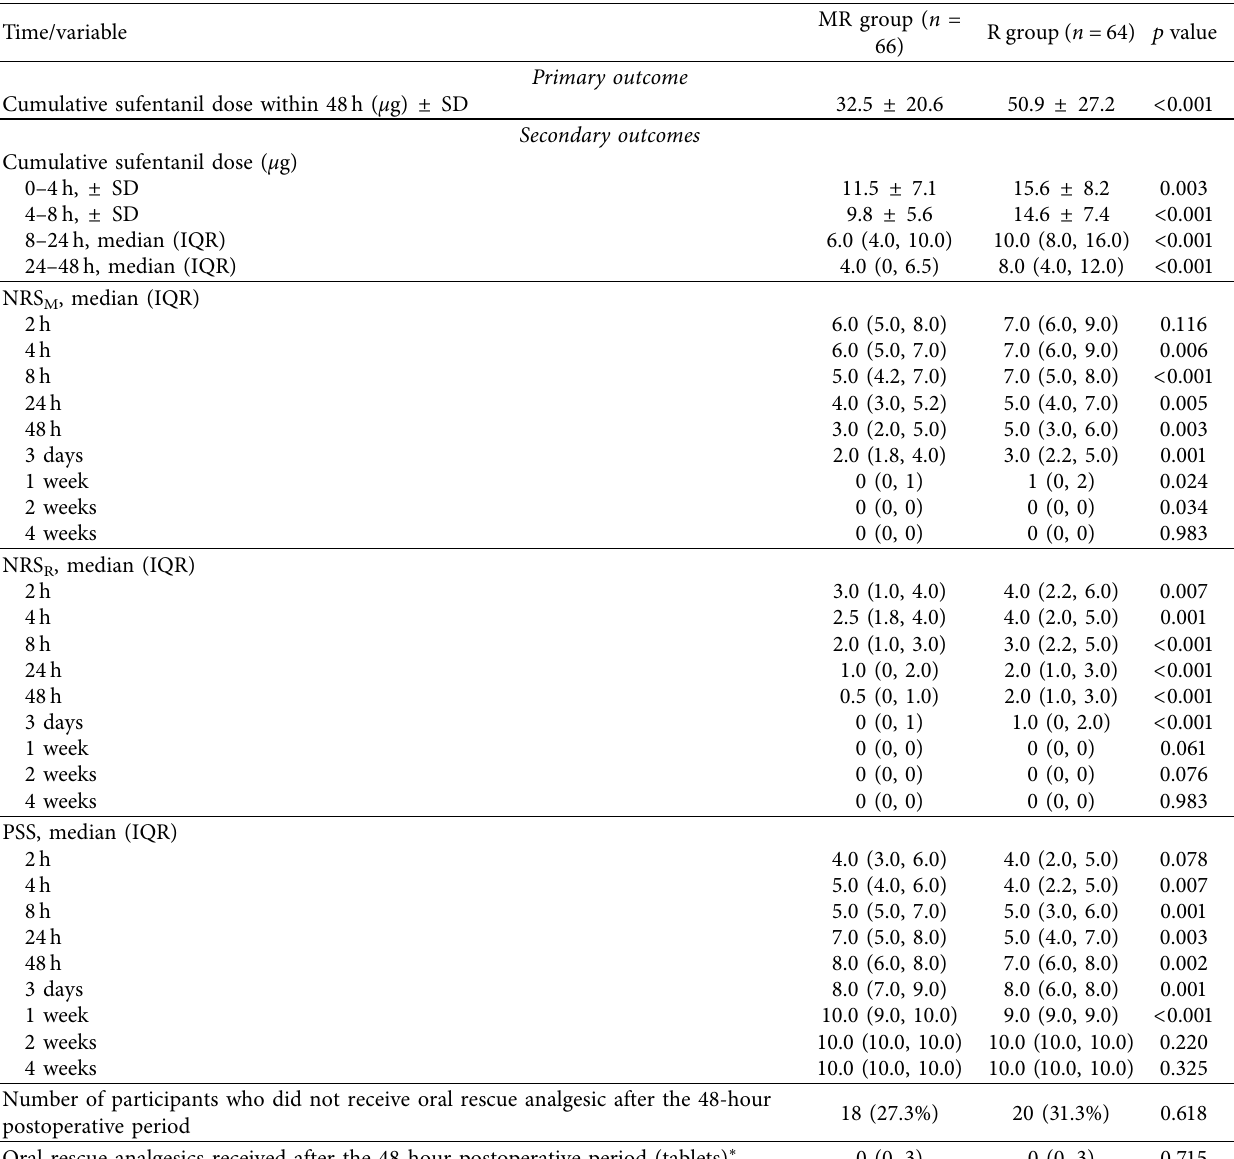
Table 2: Comparison between primary outcomes and secondary outcomes among the MR (methylprednisolone plus ropivacaine) group and the R (ropivacaine) group in the first 48 hours